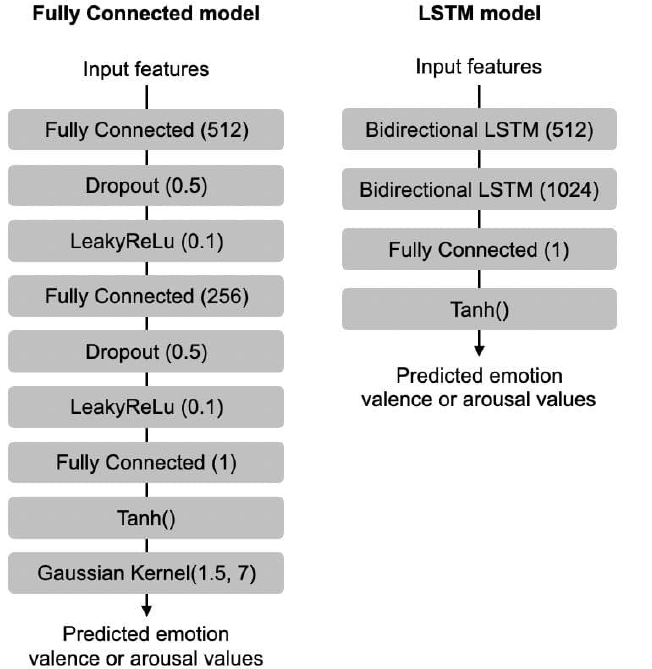
Figure 6. Baseline architectures. Left : Fully Connected architecture. Right : LSTM